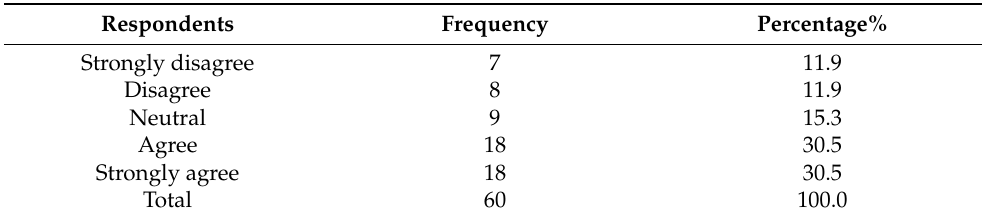
Table 13. A well-trained and experienced accountant may help enhance the company’s financial performance.